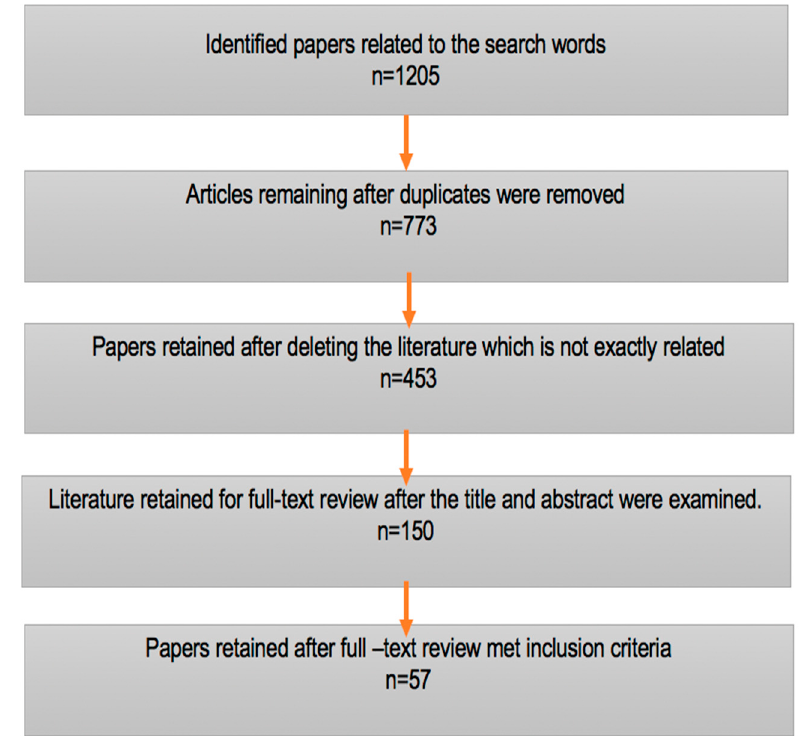
Figure 1. Flow chart of inclusion and exclusion criteria.